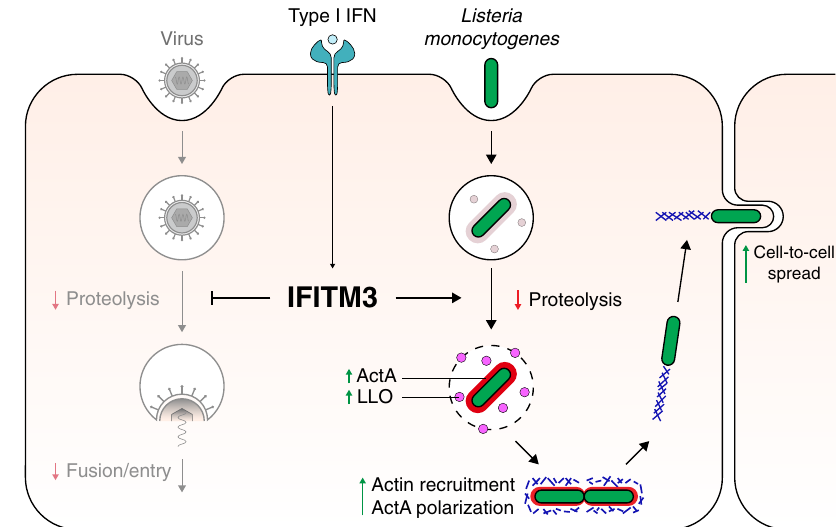
Fig. 8 Model of type I IFN-mediated effects of IFITM3. During viral infection, IFITM3 decreases proteolysis of virus capsid proteins, and restricts fusion and entry into the cytosol. During Lm infection, IFITM3-mediated suppression of proteolysis leads to increased LLO and ActA in the phagosome. After entering the cytosol, increased actin recruitment subsequently leads to an increase in cell-to-cell spread. Arrows indicate decrease (red) or increase (green) by